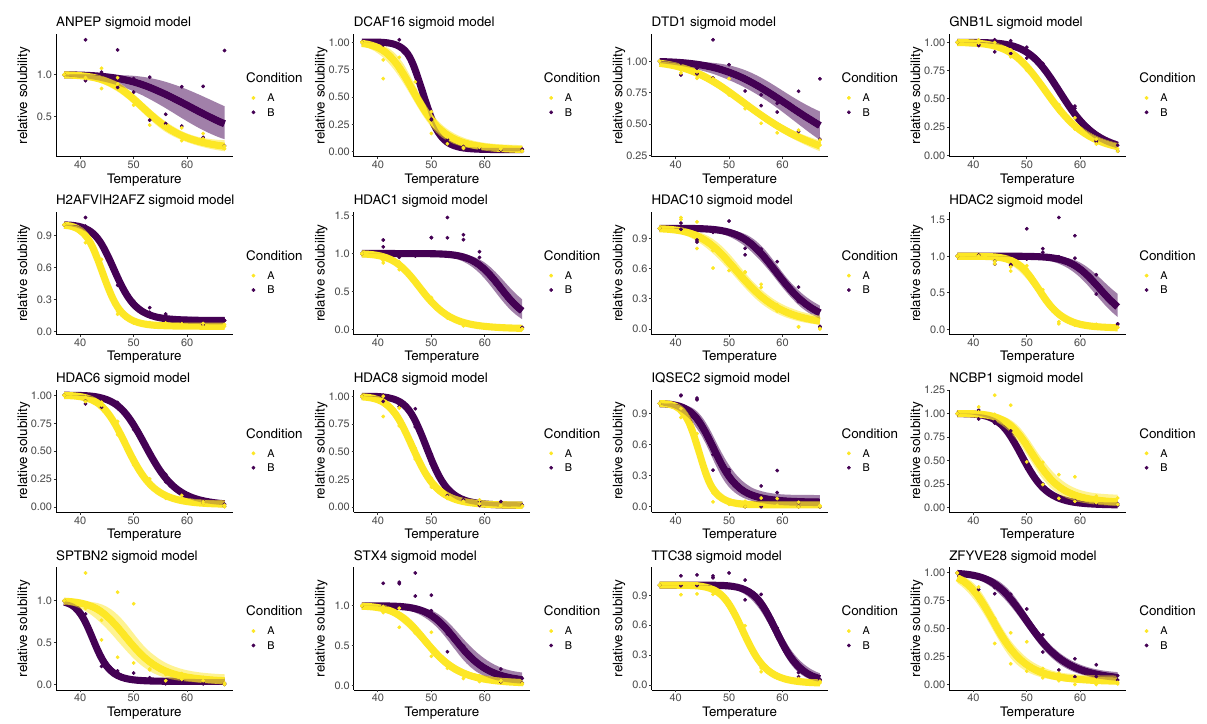
Fig. 3 Example melting curves for Panobinostat dataset. Melting pro fi les for 16 protein with posterior probability >0.99 in favour of a condition- dependent model using the Bayesian sigmoid model. Points are observed protein measurements. The inferred mean function from the sigmoid model is plotted as a line and the 95% credible band is given by the shaded region. Purple denotes the drug treated context, whilst yellow denotes the control. Statistics derived from two biological replicates, for each of two conditions each with 10 measure temperatures.